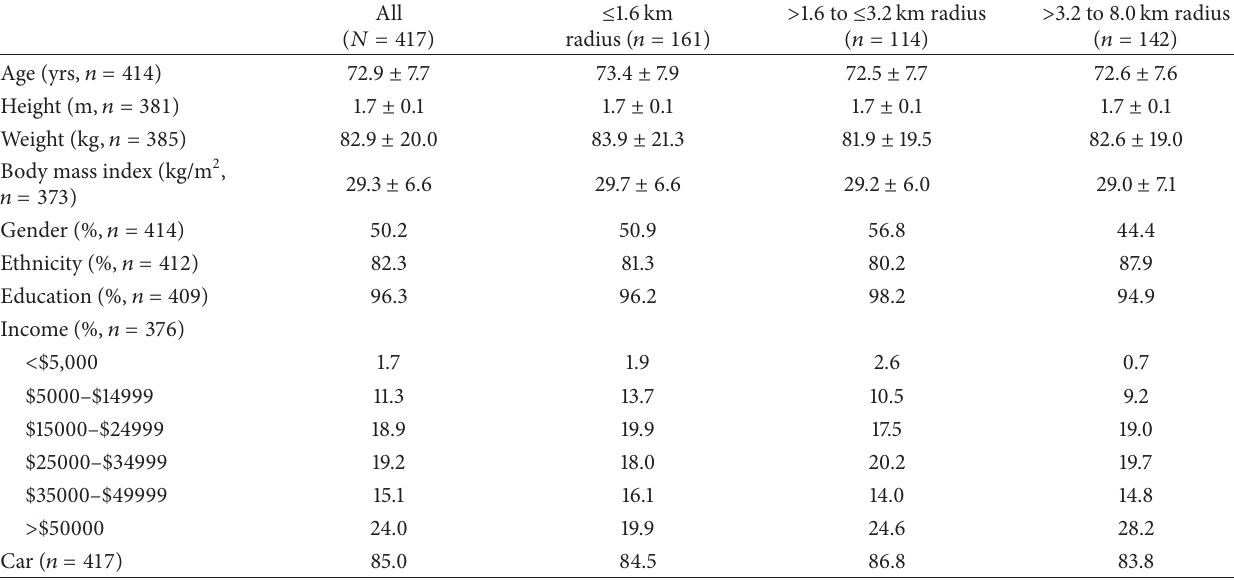
Table 1: Participant demographics (mean ± SD).